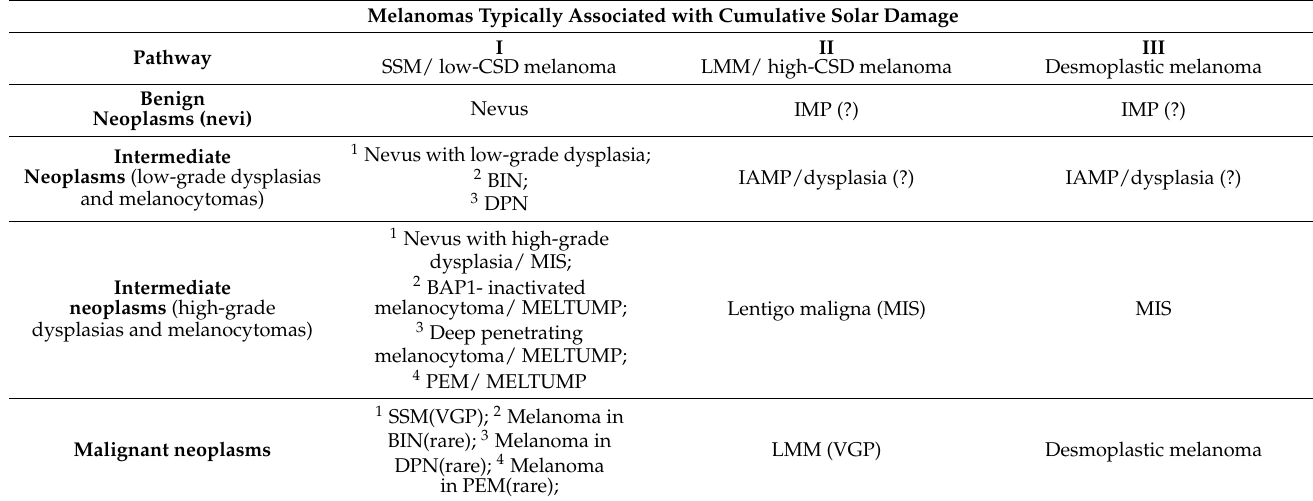
Table 2. Pathways for melanomas typically associated with cumulative solar